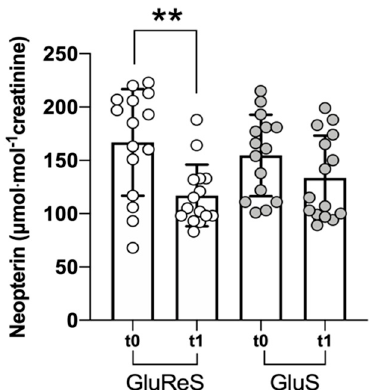
Figure 4. Scatter dot plot of neopterin levels measured in urine before (t0) and after 8 weeks (t1) of dietary supplementation with GluReS or GluS. Data are expressed as the mean ± SD. Changes over time (t1 vs. t0) was significant at ** p < 0.01.